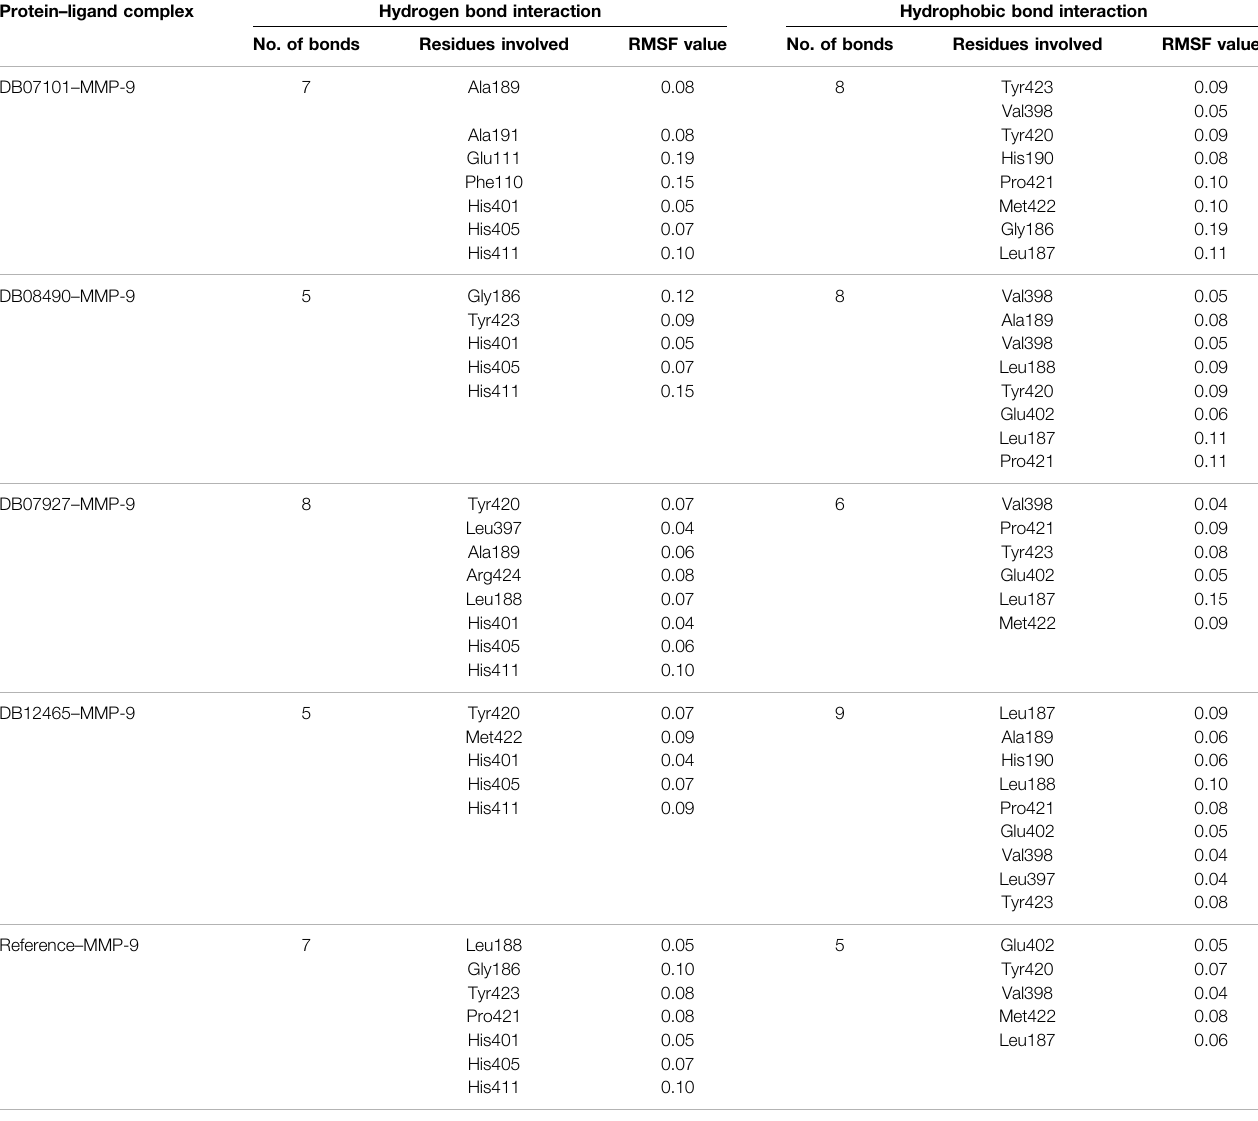
TABLE 2 | Active site residues and their RMSF values (angstrom).